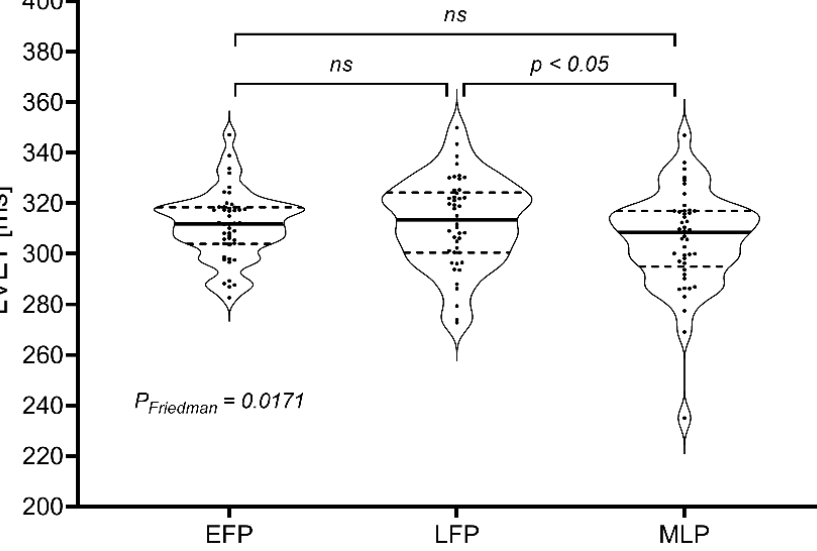
Figure 1. Violin plot for pairwise comparison of LVET measurements in the early follicular phase, late follicular phase and mid-luteal phase of the menstrual cycle. Abbreviations: EFP—early follic- ular phase; MLP—mid-luteal phase; LFP—late follicular phase; LVET—left ventricle ejection time; ns—not